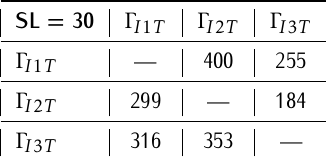
— oara to Deva with SL=30 ,